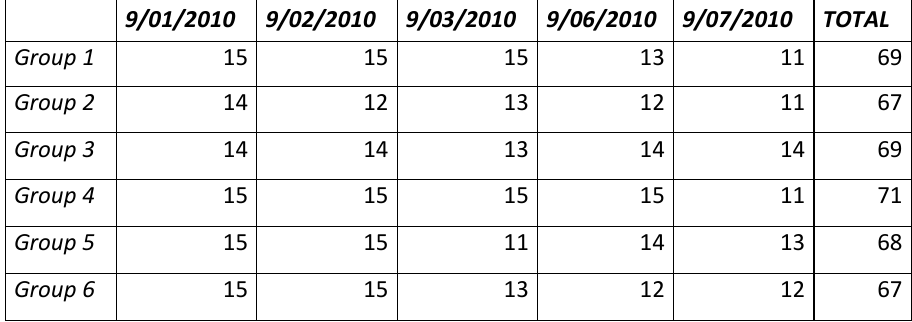
Table 2. Attendance at each of the 6 "preEnginyCAT" courses. Number of students